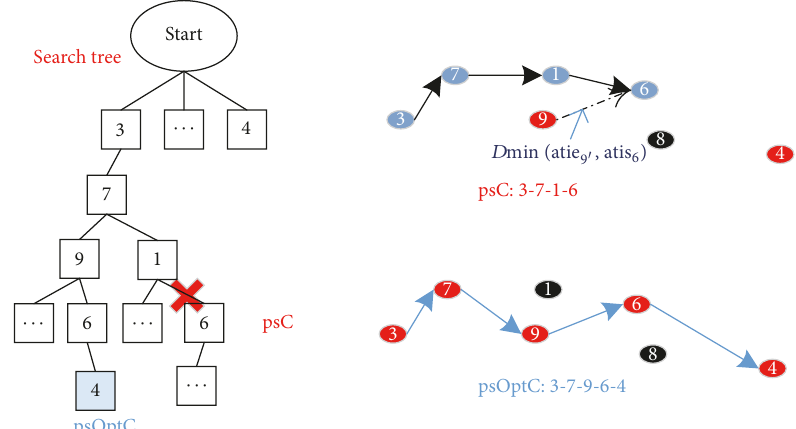
Figure 5: Schematic diagram of the segment domination based pruning